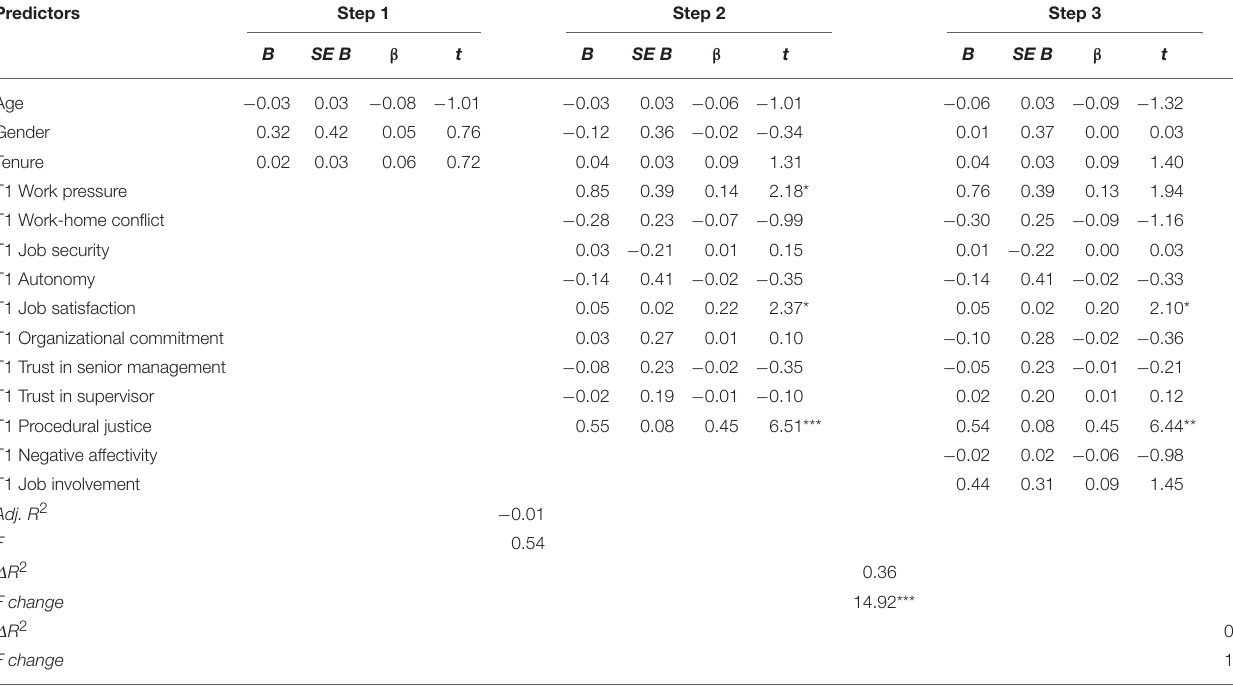
TABLE 4 | Multiple regression analyses of all predictors of T2 procedural justice for the academic staff category. Predictors